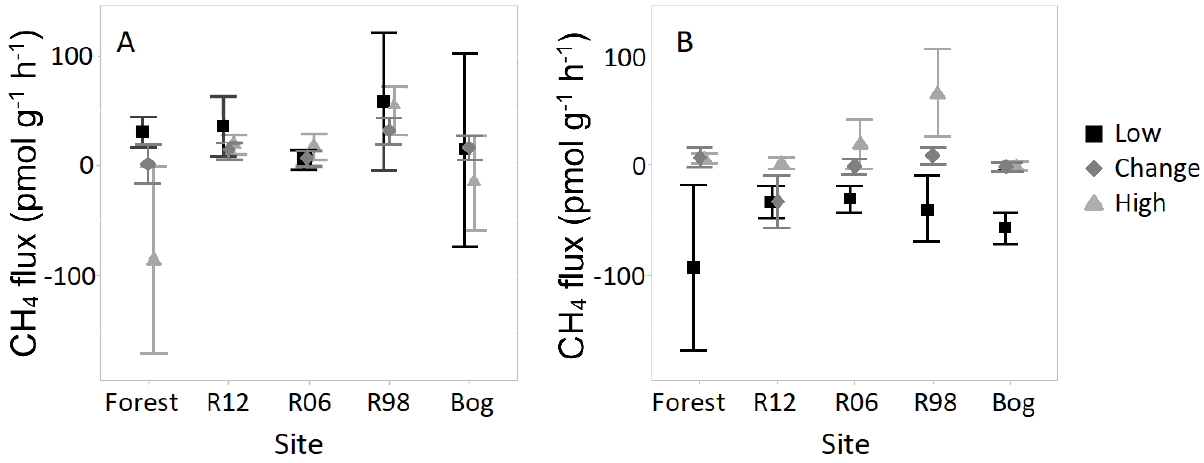
Figure 4. Methane (CH ) fluxes from the different core depths, points are averages over all measurement 4 rounds (n=5). Error bars are standard errors. A) Shallow cores, B) Deep